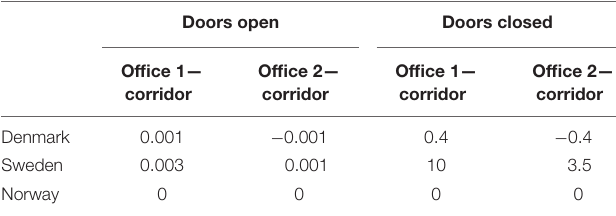
TABLE 2 | Pressure differences (Pa) across